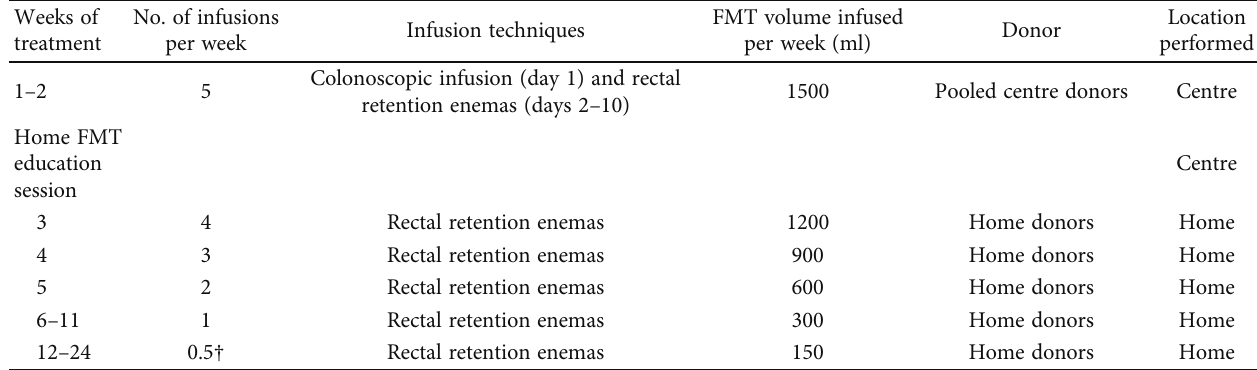
Table 1: Six-month FMT